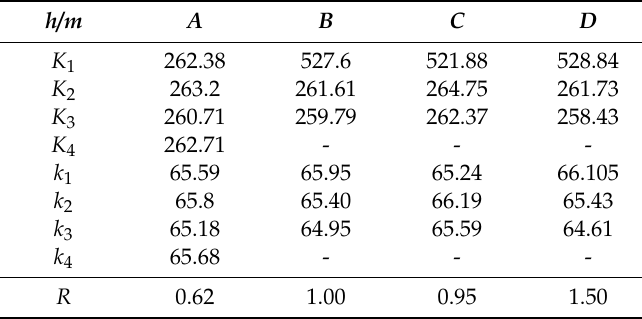
Table 9. 0.6 Q e ffi ciency analysis.